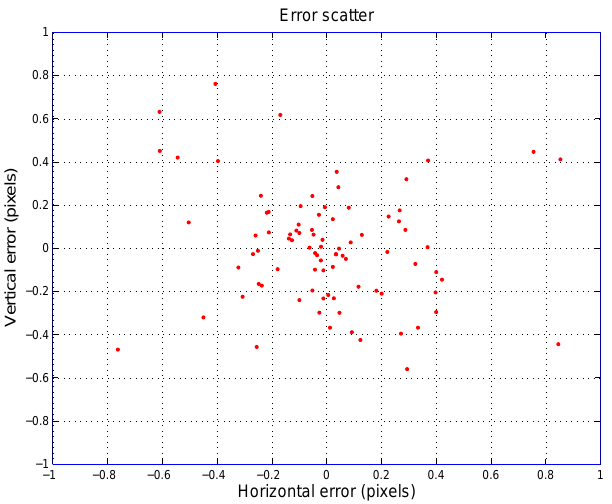
Fig. A3. Scatter plot of the difference between the HAARP image position of identified stars and the corresponding position calculated from the sky position of the stars and the camera parameters.